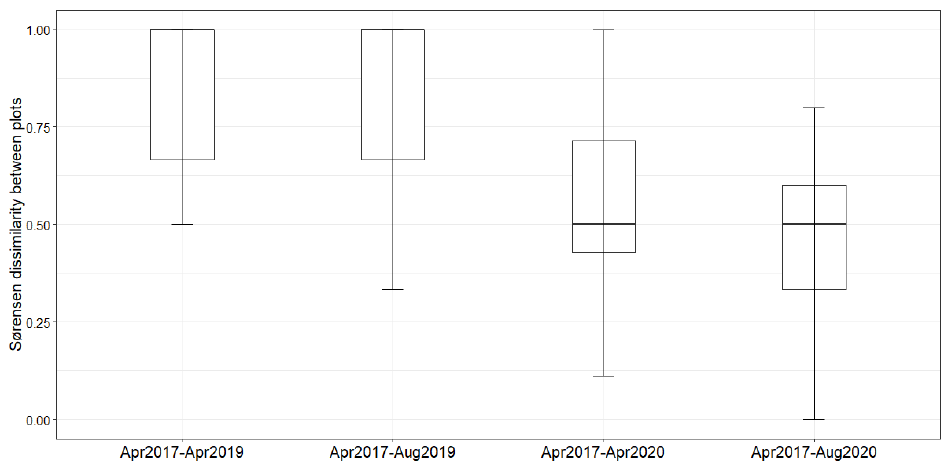
Figure 2. Sørensen pairwise dissimilarity ( β sor ) between pre-pipeline (April 2017) and after (April 2019, August 2019, April 2020, and August 2020) pipeline construction on functional traits at the species and community level.